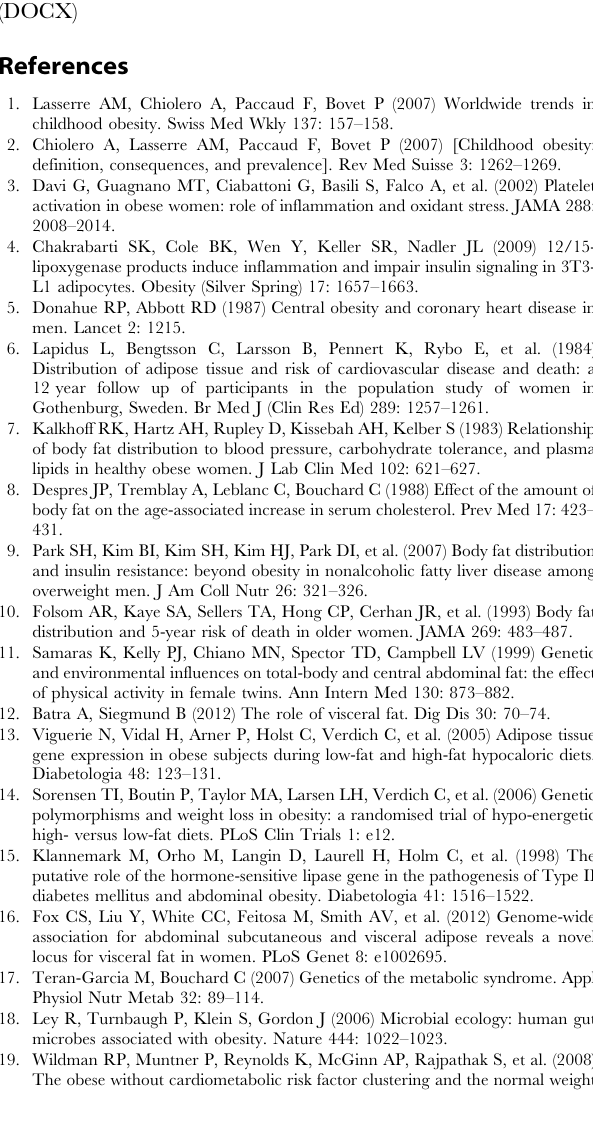
Table S1 Descriptive statistics of subjects stratified according to intraperitoneal fat volume. Table S2 Descriptive statistics of subjects stratified according to intraperitoneal/subcutaneous fat ratio. Table S3 Metabolite variations across of subjects stratified according to intraperitoneal fat volume. Table S4 Metabolic variations across subjects stratified according to intraperitoneal/subcutaneous fat ratio. Table S5 Metabolite VIP ranking based on PLS models generated at V2 +